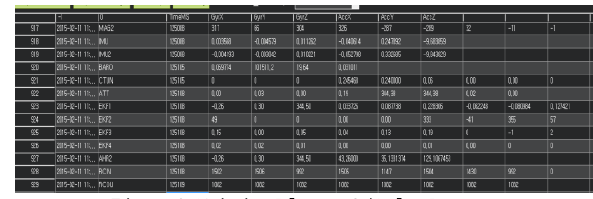
Figure 6. Mission Planner S/W log Brower.